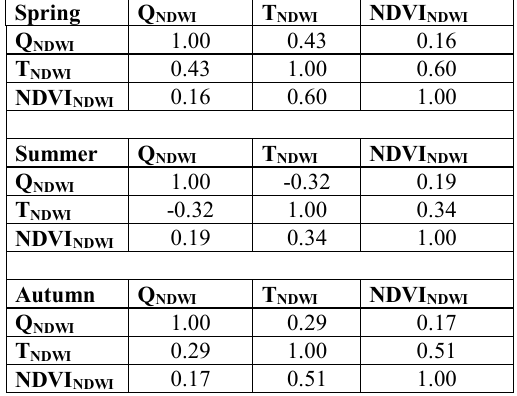
Table 6. The correlation coefficients between the precipitation (Q), air temperature (T) and NDVI obtained for the growing seasons on the base of NDWI data The computations were performed for each growing